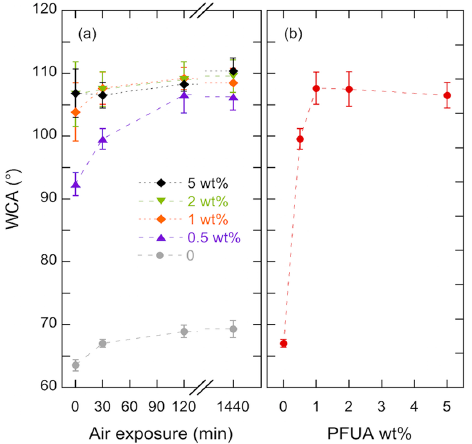
Figure 3. Water contact angle vs. ( a ) air exposition time for pure HBP and fluorinated flat surfaces for different concentrations of PFUA as indicated; and ( b ) PFUA concentration for HBP coatings polymerized after 30 min of air exposure.